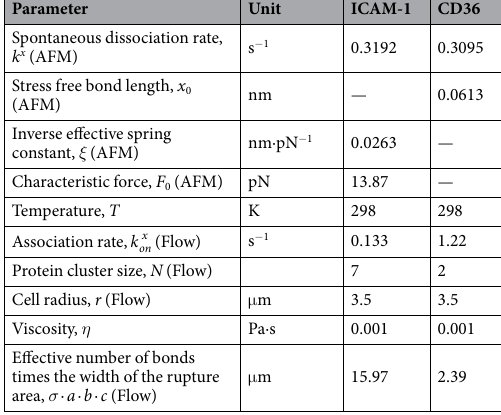
Table 1. Fitting parameters for AFM and flow assay.